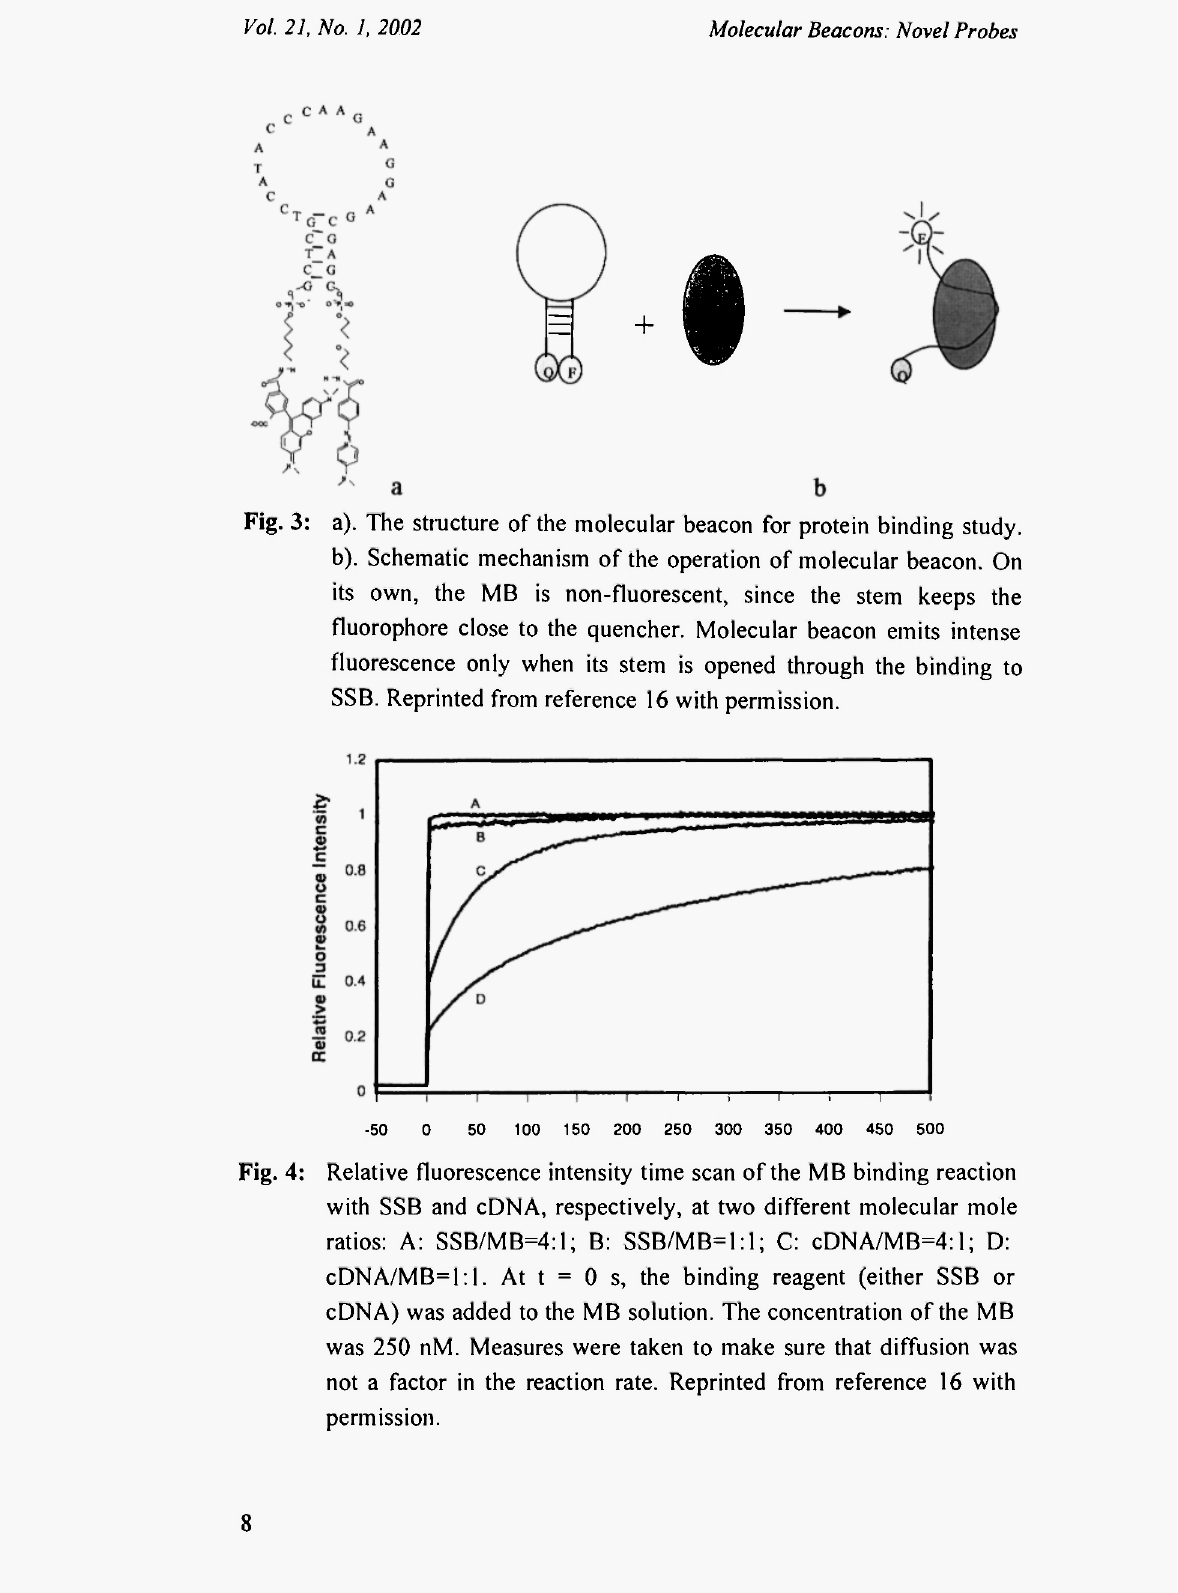
Fig. 4: Relative fluorescence intensity time scan of the MB binding reaction with SSB and cDNA, respectively, at two different molecular mole ratios: A: SSB/MB=4:1; B: SSB/MB=1:1; C: cDNA/MB=4:l; D: cDNA/MB=l:l. At t = 0 s, the binding reagent (either SSB or cDNA) was added to the MB solution. The concentration of the MB was 250 nM. Measures were taken to make sure that diffusion was not a factor in the reaction rate. Reprinted from reference 16 with